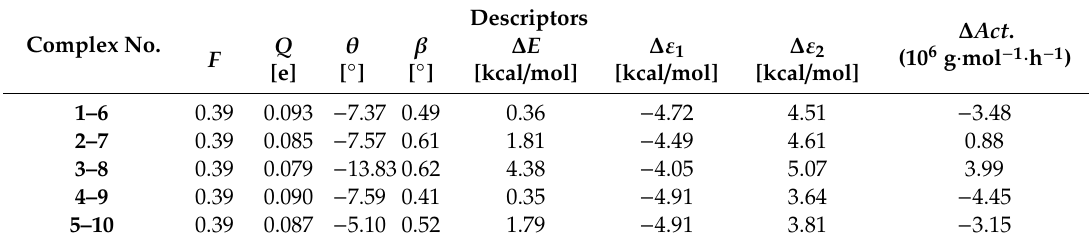
Table 7. The variation values of Hammett constant ( F ), e ff ective net charge ( Q e ff ), open cone angle ( θ ), bite angle ( β ), energy di ff erence ( ∆ E ) and HOMO–LUMO energy gap ( ∆ ε 1, ∆ ε 2 ) between Ni1 and Ni2 analogues together with the variation of catalytic activities ( ∆ Act .). Complex